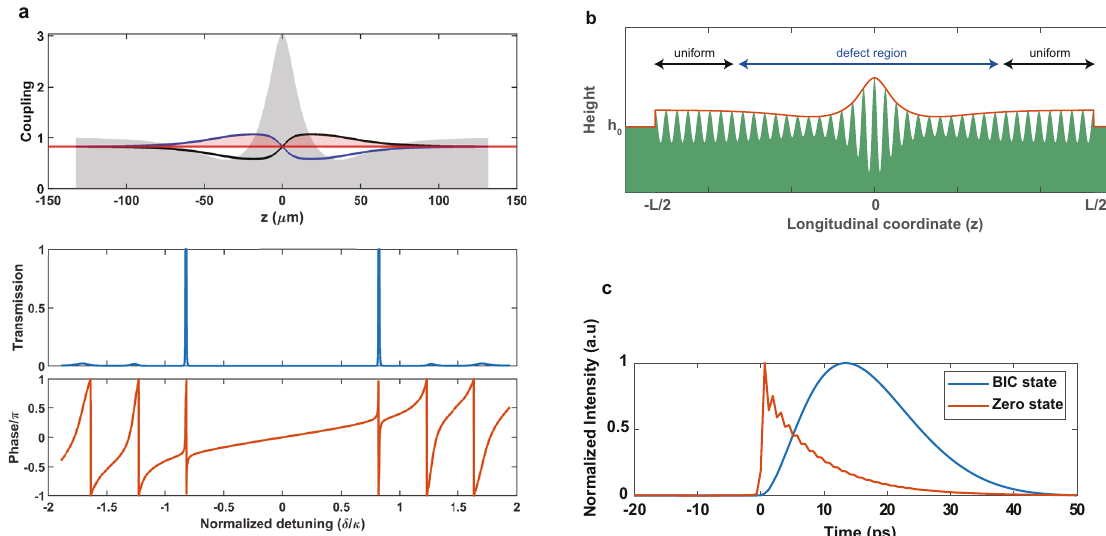
Fig. 4 Bound states in the continuum. a Coupling potential obtained by degenerate SUSY for two degenerate states shown in black and blue. Both states decay into the same channel, two states at the same frequency can interfere, leading to Friedrich – Wintgen BIC. For a fi nite grating, the transmission amplitude for BIC states is one, and the phase shift across the state sweeps 2 π . In the ideal case for an in fi nite grating, the phase does not change. b The structure of grating for coupling potential supporting degenerate states. The increase in height is still within the weak grating limit. The grating period has been magni fi ed for visualization. c Comparison of the temporal response of zero detuning state and the BIC state. The ideal temporal integrator has a unit step impulse response. However, the leakage of energy reduces the temporal bandwidth and imposes a strict restriction on the different sections of the grating. As the localization of fi elds in the BIC state occurs due to interference, the BIC integrators do not have length